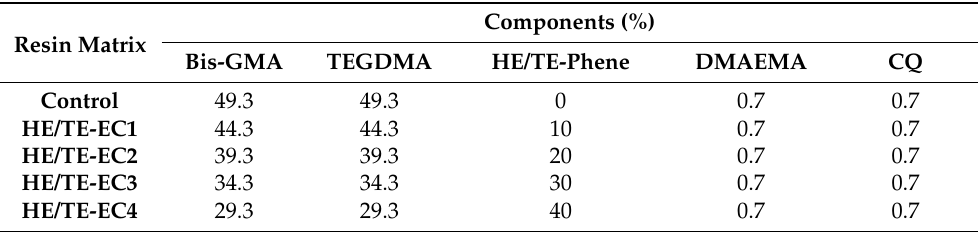
Table 1. Composition of resin matrix for each hexaethylene (HE) or triethylene (TE) experimental resin composite